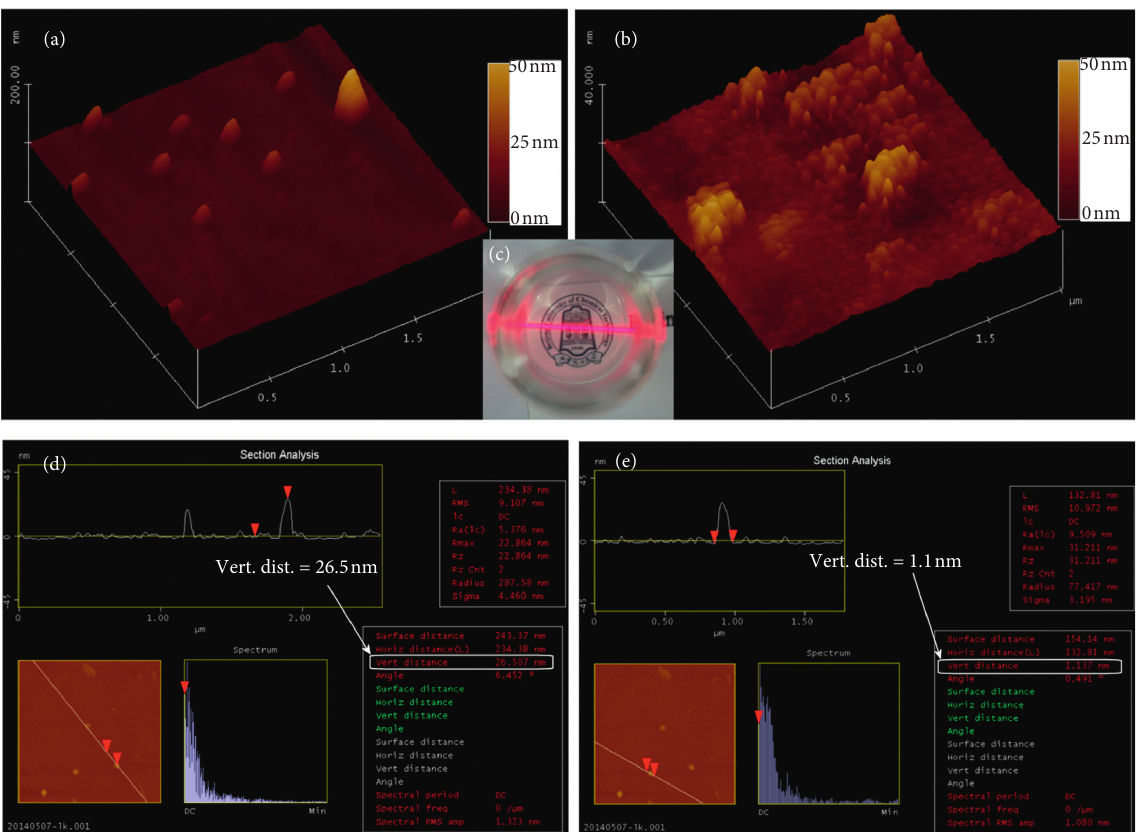
Figure 5: AFM diagrams of (a) LEuH-Cl aggregate material, (b) LEuH-flocs nanosheets, (c) the dispersion of an incident light by an aqueous colloidal solution of LEuH-flocs nanosheets (pH � 7) demonstrating “the Tindal effect” of the dissolved powder, (d) AFM analysis of LEuH- Cl aggregates, and (e) AFM analysis of LEuH-flocs